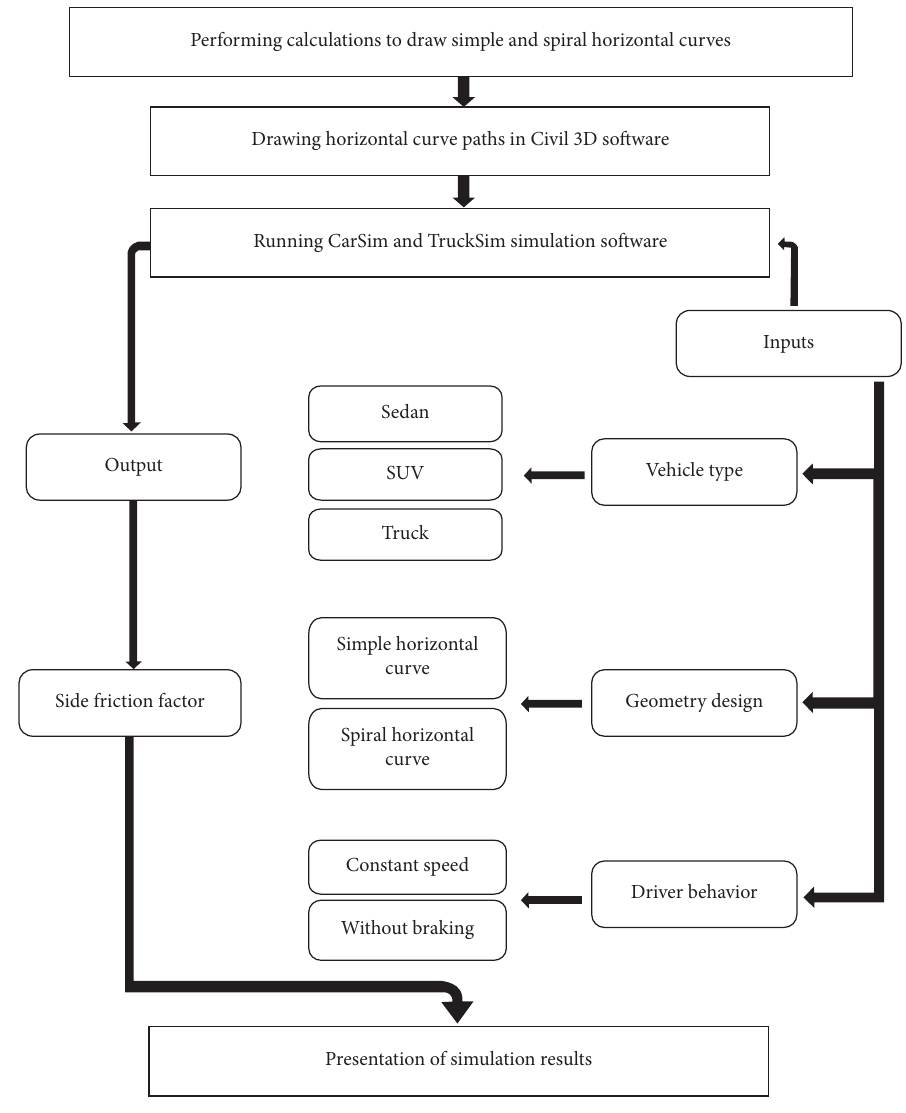
Figure 1: Flowchart introducing the research